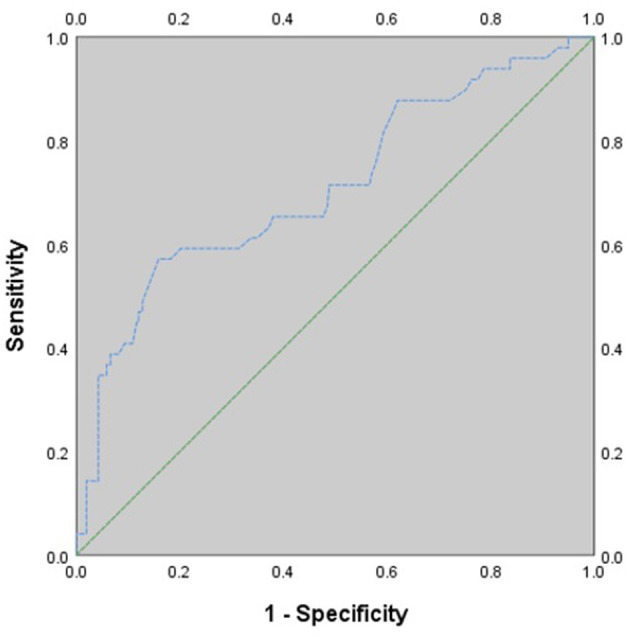
ROC curve for 1-year MACE. AUC, area under the curve; CI, confidence interval.